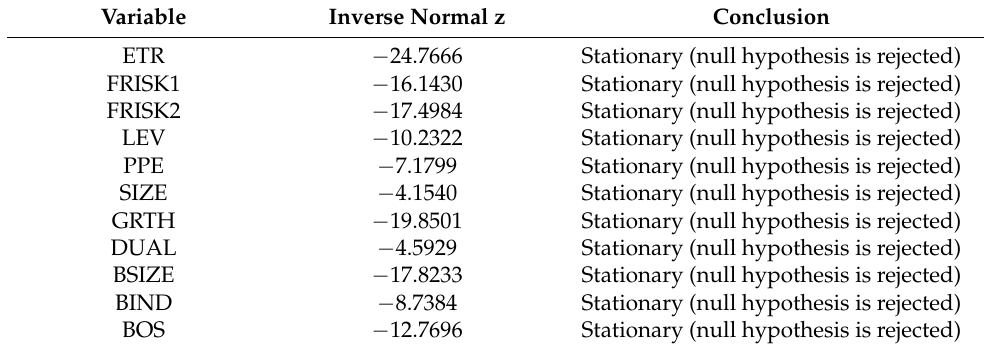
Table 4. Results of Unit root test.